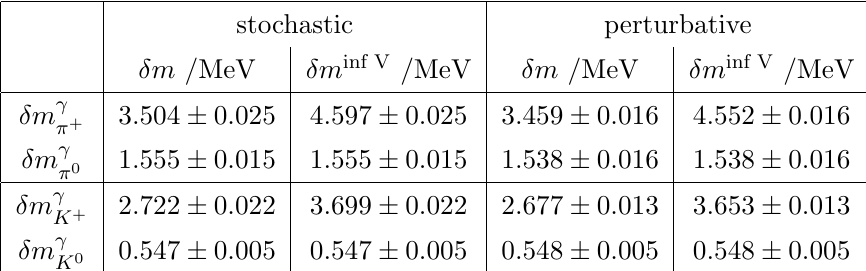
Table 1 . Results for the QED correction to the meson masses from the stochastic and the pertur- bative method. For both methods the left column shows the result in (cid:12)nite volume and the right panel the result in in(cid:12)nite volume using (4.12). Note, that these results have not been obtained at the physical point. The large e(cid:11)ect on the neutral pion mass is due to a small amount of residual chiral symmetry breaking in our Domain Wall Setup (cf. discussion in section 3 and in [3]).